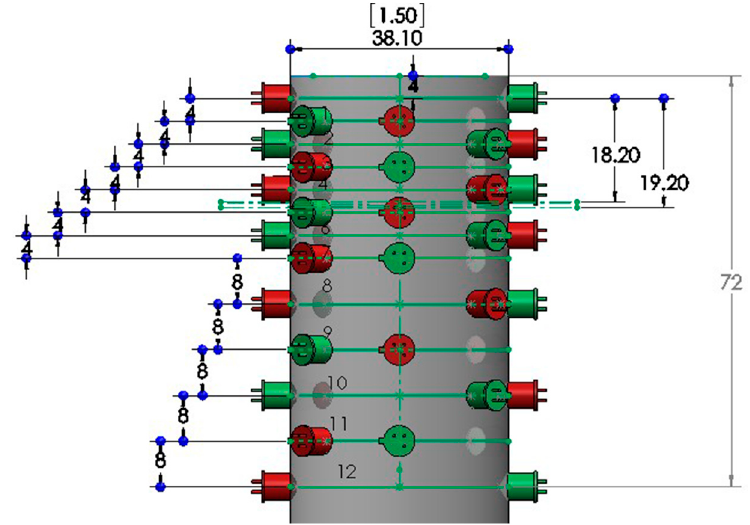
Figure 4. Diagrammatic representation of the bench velocimeter. Paired LED sensors, with green being the emitter and red being the receiver for each section. The gun to be tested is placed on the top of the velocimeter and the bolt turns on and off each LED sensor pair as it passes; the velocity of the bolt is then calculated. Animals 2019 , 9 , x